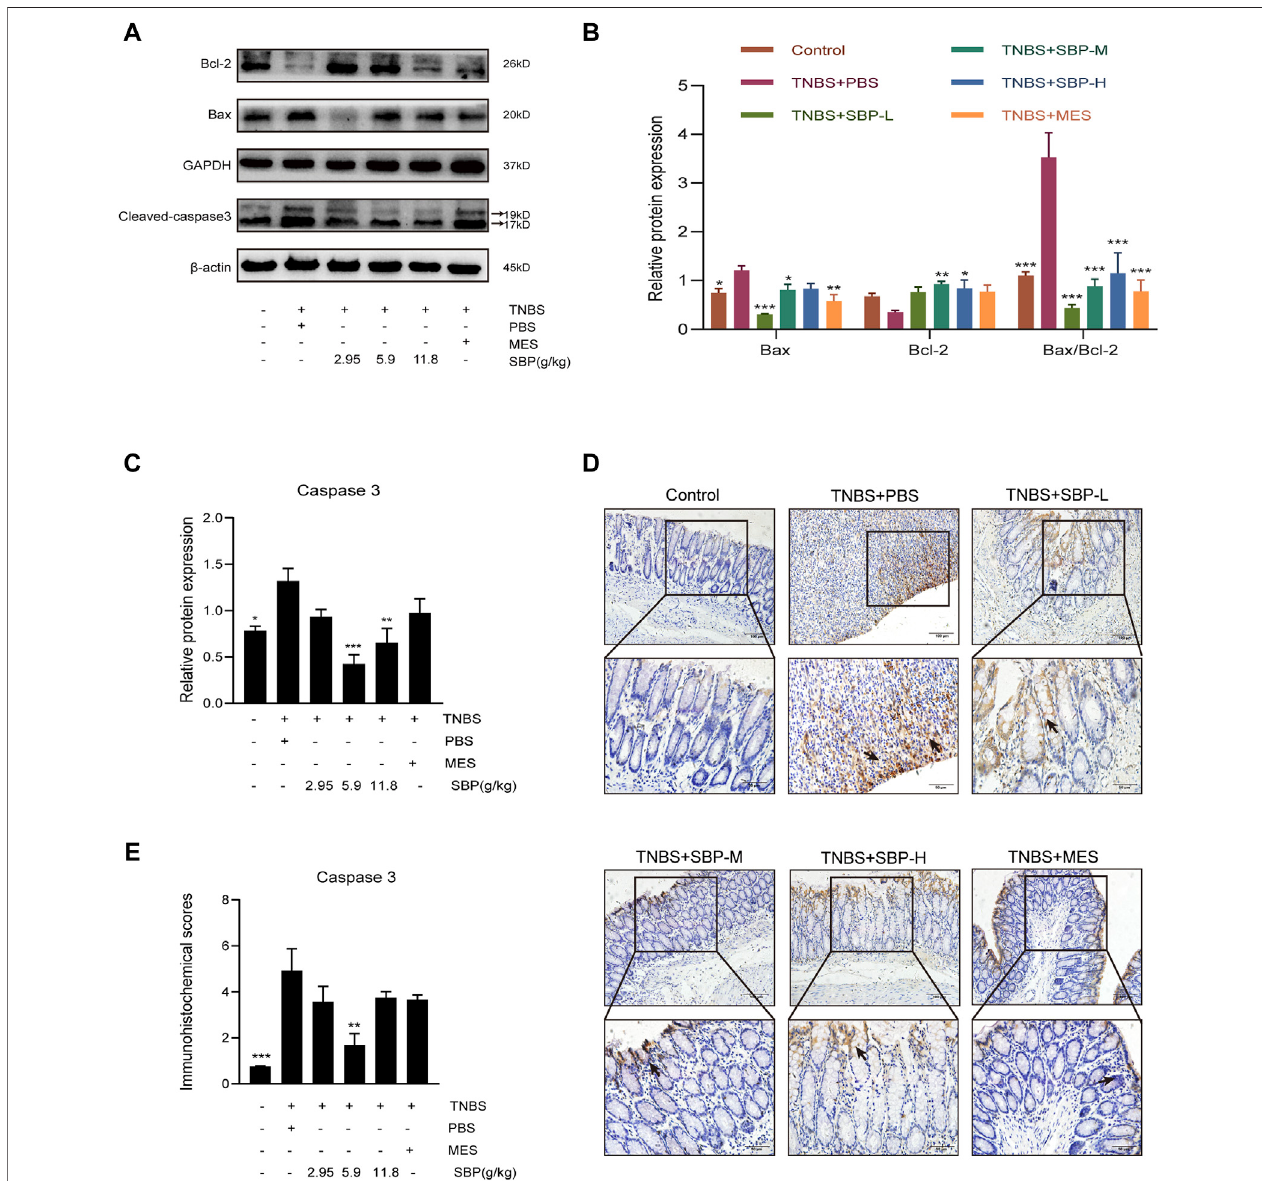
FIGURE 4 | Effect of SBP on the apoptosis in TNBS-induced colitis . (A – C) Representative western blot analysis of Bcl-2, Bax, Cleaved-caspase 3 levels in colon tissue. (D,E) Immunohistochemistryanalysisofcleavedcaspase-3.Scalebar=100 µM(×200);Scalebar=50 µM(×400).vs.TNBS+PBSgroup, n =3rats/group.Data shown asmeans ± SEM. * p < 0.05, ** p < 0.01, *** p < 0.001. SBP-L, low-dose SBP group (2.95 g/kg); SBP-M, medium-dose SBP group (5.9 g/kg); SBP-H, high-dose SBP group (11.8 g/kg).